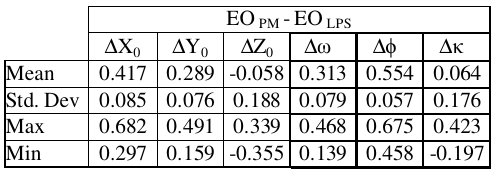
Table 5. Statistics of differences in EO parameters (lengths in meters, angles in